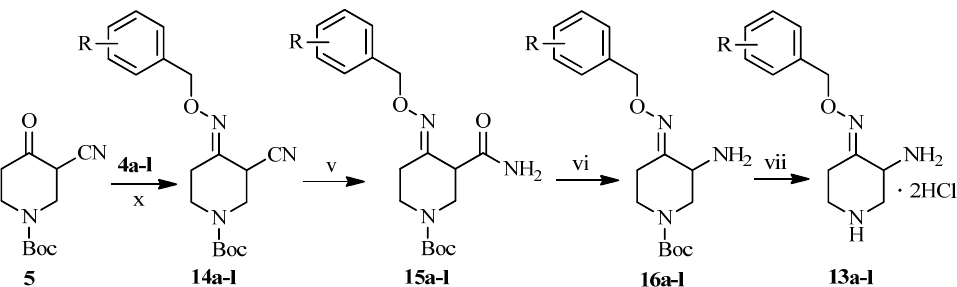
Scheme 3. Synthesis of piperidine derivatives 13a – l